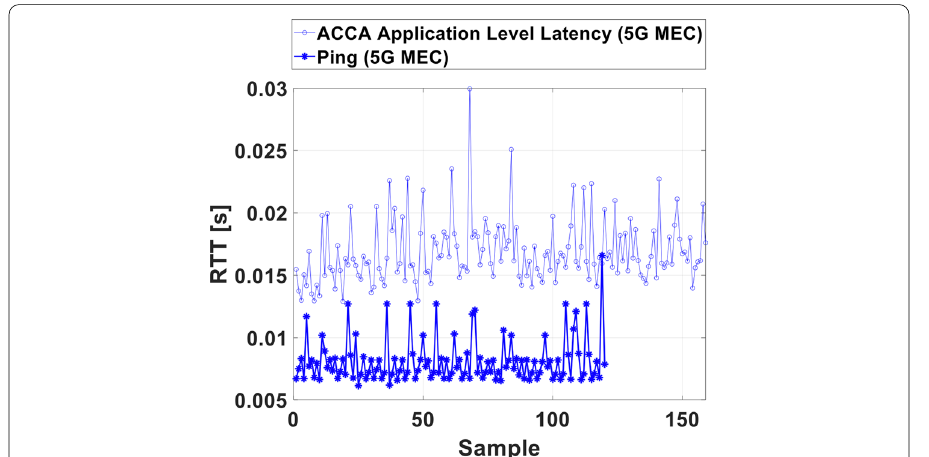
Fig. 8 Ping RTT and ACCA application‑level